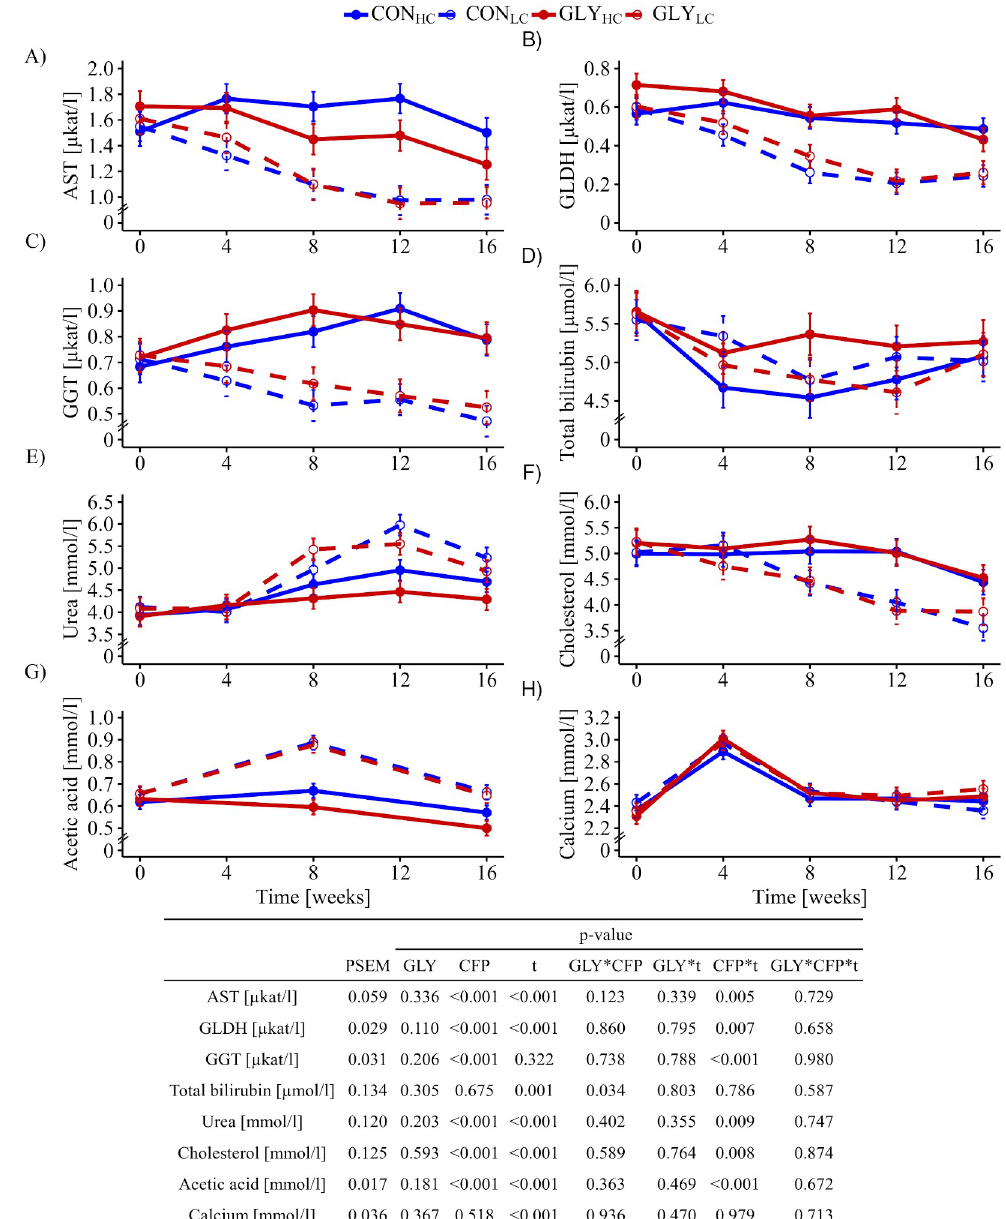
Fig 1. Influence of glyphosate residues and different concentrate feed proportions in diets of cows on biochemical blood parameters. Serum AST (A), GLDH (B), GGT (C), total bilirubin (D), urea (E), cholesterol (F), acetic acid (G) and calcium (H) of dairy cows fed with either a GLY-contaminated (GLY groups) or control (CON groups) diet consisting of high (HC, 60%) or low (LC, 30%) concentrate feed proportions were measured (CON HC , n = 16; CON LC , n = 16; GLY HC , n = 15; GLY LC , n = 14). Values are presented as LS means ± standard error of the mean. Parameters were analyzed with values from week 0 as covariate. PSEM = pooled standard error of the mean; GLY = glyphosate; CFP = concentrate feed proportions; t = experimental time; AST = aspartate aminotransferase; GGT = γ -glutamyltransferase; GLDH = glutamate dehydrogenase; CON = control; HC = high concentrate proportion in the diet; LC = low concentrate proportion in the diet.